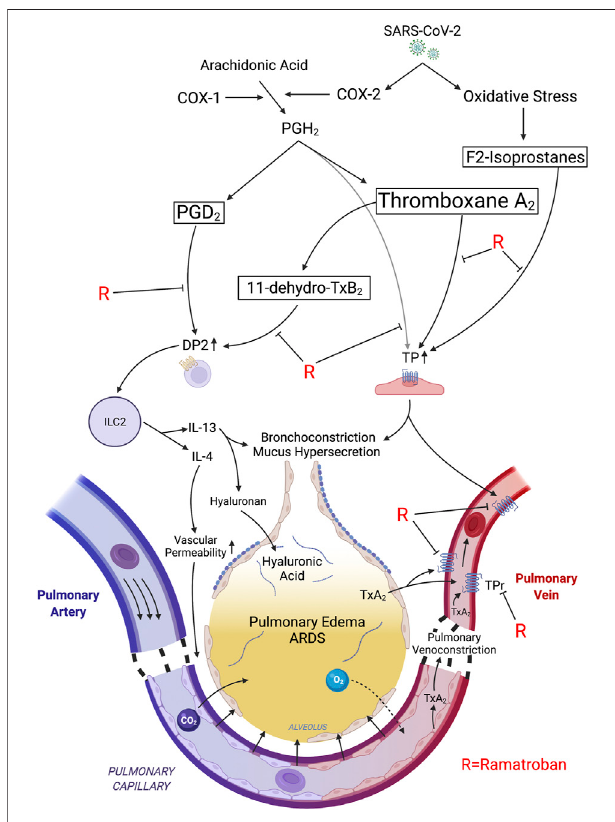
FIGURE 1 | Proposed mechanisms of rapid relief in respiratory distress following ramatroban administration during acute SARS-CoV-2 infection. SARS-CoV-2 induced expression of COX-2 generates PGH 2 which is converted into thromboxane A 2 >> PGD 2 . Oxidative stress-associated free radicals initiate nonenzymatic peroxidation of arachidonic acid leading to F2-isoprostane generation. PGH 2 , TxA 2 , and F2-isoprostanes stimulate thromboxane prostanoid receptors (TP). TP stimulation induces pulmonary venoconstrictionleadingtoanincreaseintranscapillarypressureinpulmonary microvasculature, and transudation of fl uid into the alveoli, thereby causing impaired gas exchange and ARDS. The TxA 2 /TP axis also induces